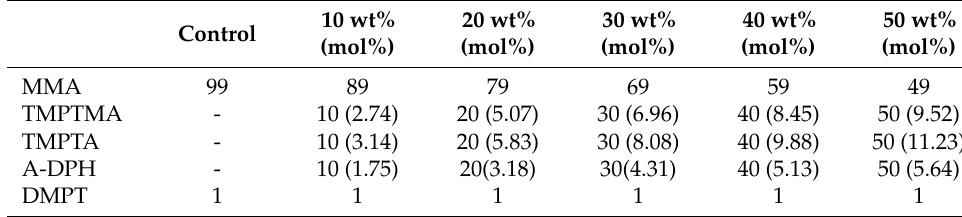
Table 2. Composition of samples used in this study.